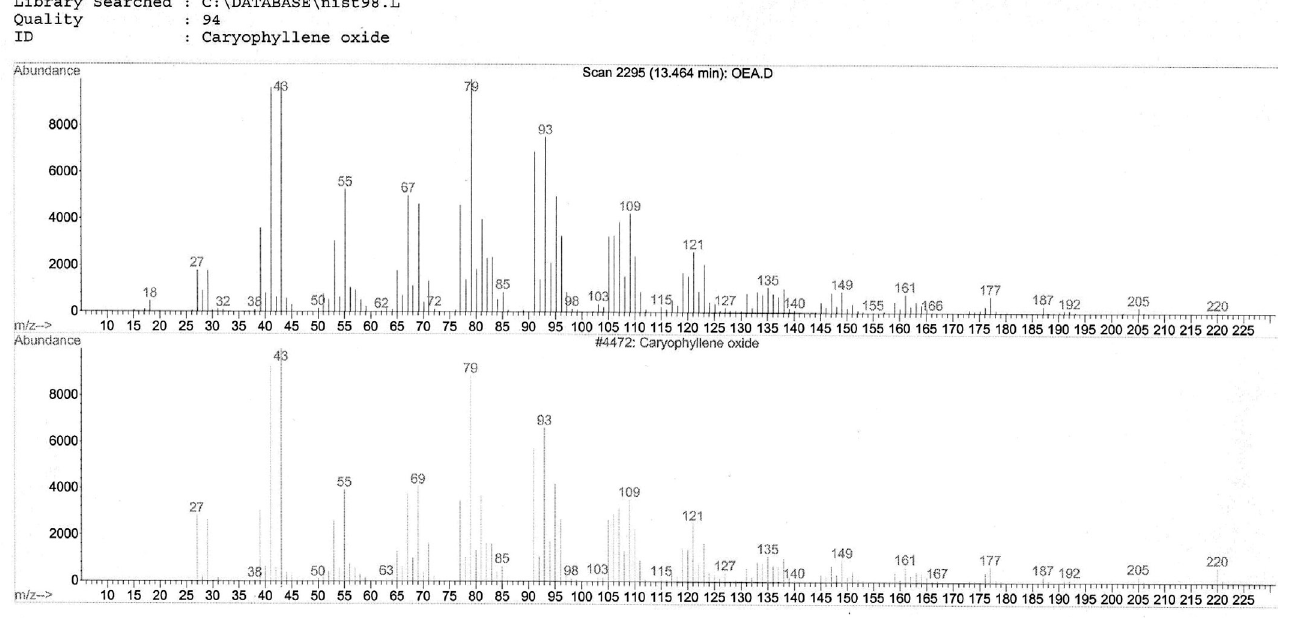
FIGURE 2 - Mass spectrum of caryophyllene